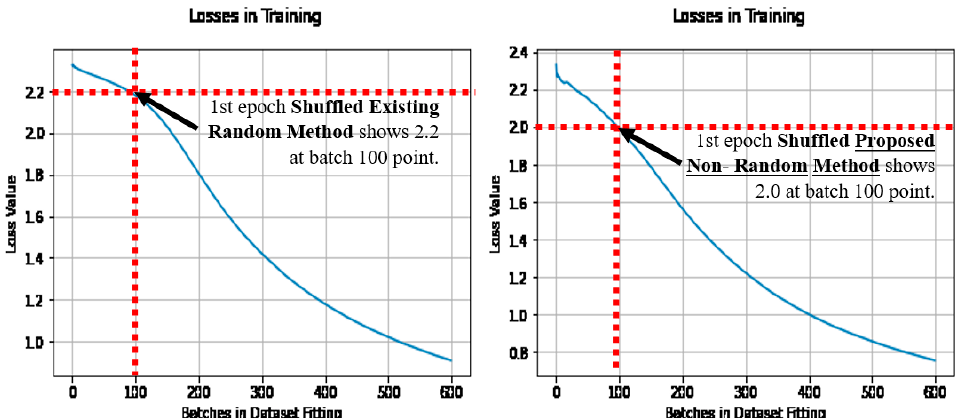
Figure 8. Losses over batches in fitting, when shuffled (with the existing method ( left ) and the proposed method ( right )).